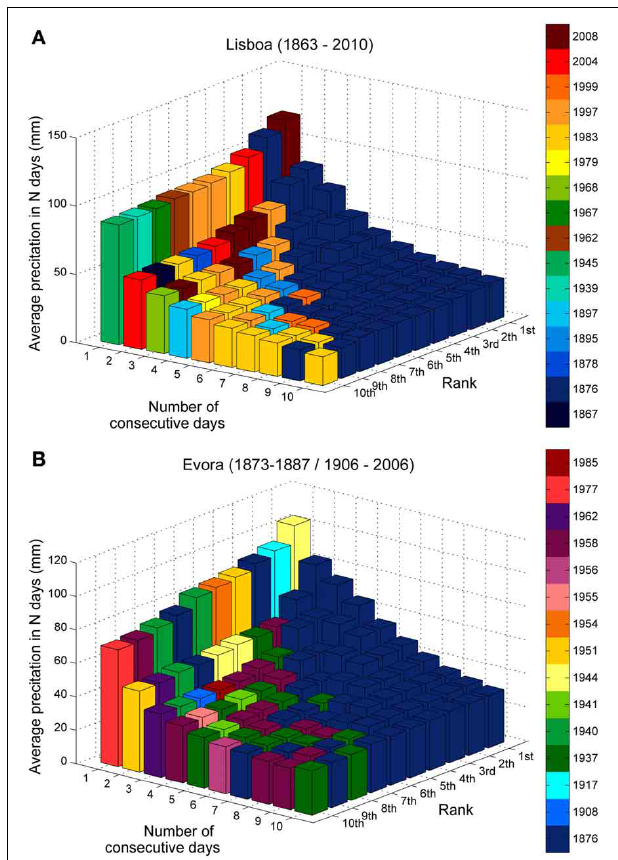
FIGURE 5 | The 10 highest values (rank) of accumulated precipitation from 1 to 10 consecutive days in (A) Lisbon for the period 1863–2010 and (B) Evora for the period 1873–1887, 1906–2006 respectively. The color bar scale represents the year with an extreme event that is included in the graphic. The vertical axis represents the average precipitation amount in 24h.